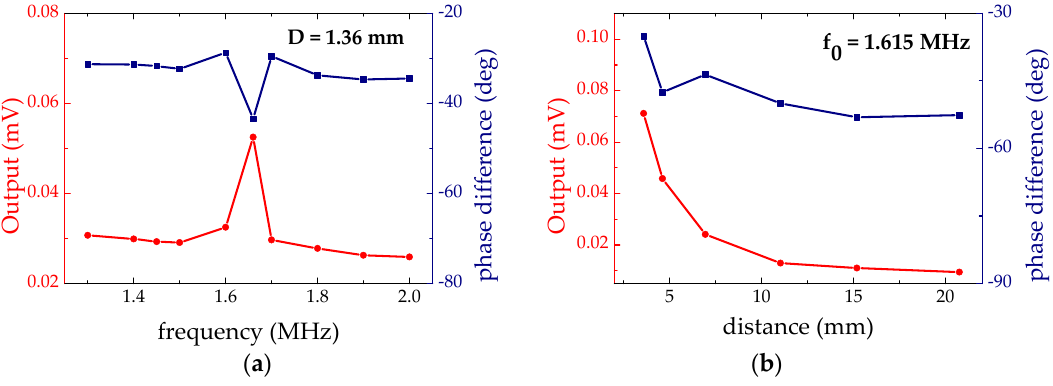
Figure 9. ( a ) Readout of the receiver at 1.36 mm from the transmitter. ( b ) Receiver signals taken at different distances from the source.